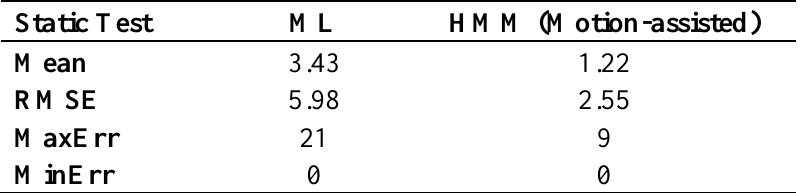
Table 5. Static Test (Unit: m).